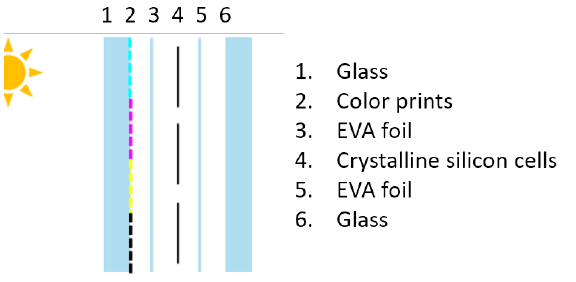
Figure 1. Layers comprising a multi-coloured glass-glass photovoltaic laminate. A translucent multi-coloured motif (layer 2) is printed on the inner surface of the front glass sheet